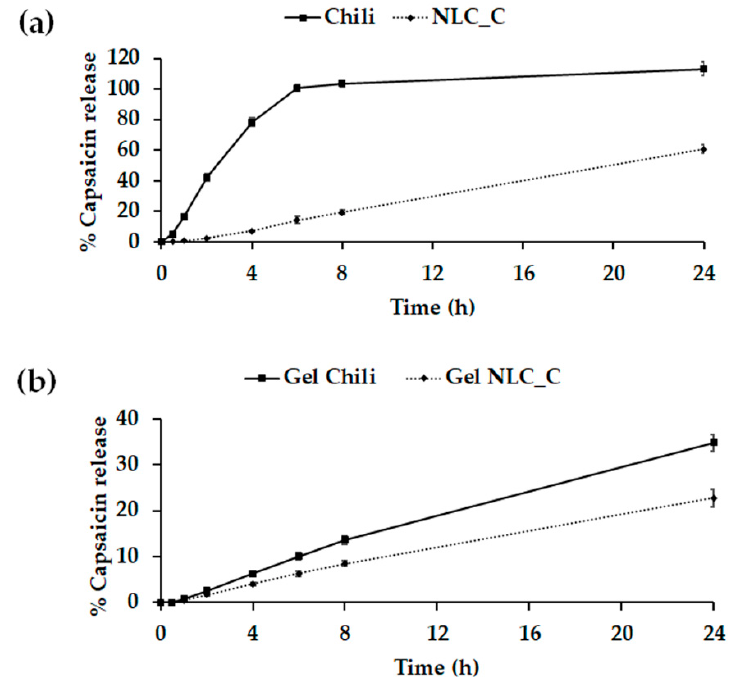
Figure 5. In vitro release study of ( a ) aqueous dispersions—chili extract and NLC_C—and ( b ) gel formulations; Gel Chili and Gel NLC_C, at various time points within 24 h. Abbreviations: NLC_C, chili-extract-loaded-nanostructured lipid carriers; Gel Chili, chili-extract-incorporate-in-gel; Gel NLC_C, chili-extract-loaded NLC-incorporate-in-gel. Table 3. Correlation coefficient (R 2 ) values of the capsaicin-release kinetic models. Formulation